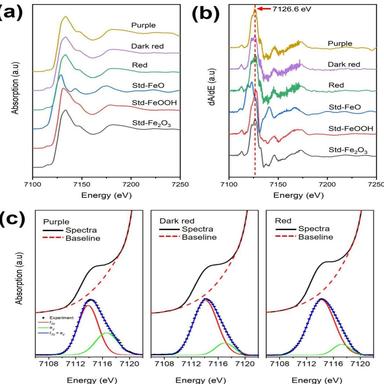
(a) XANES region of the normalized Fe K-edge X-ray absorption spectra of pigment sample, (b) first derivative XANES region of the normalized Fe K-edge Xray absorption spectra of pigment sample, and (c) Baselined pre-edge region of the normalized Fe K-edge X-ray absorption spectra of purple, dark red and red pigment samples and deconvoluted pre-edge region of spectra of pigment samples.